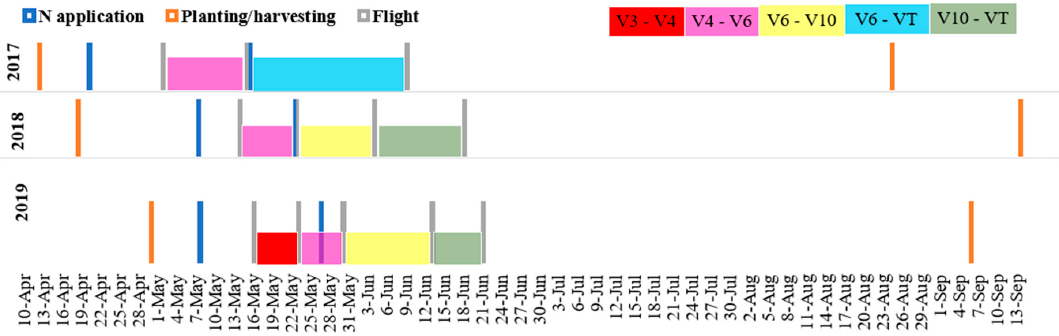
Figure 4. N applications, planting/harvesting, and flight dates during the different phenological stages of corn for 2017, 2018, and 2019.